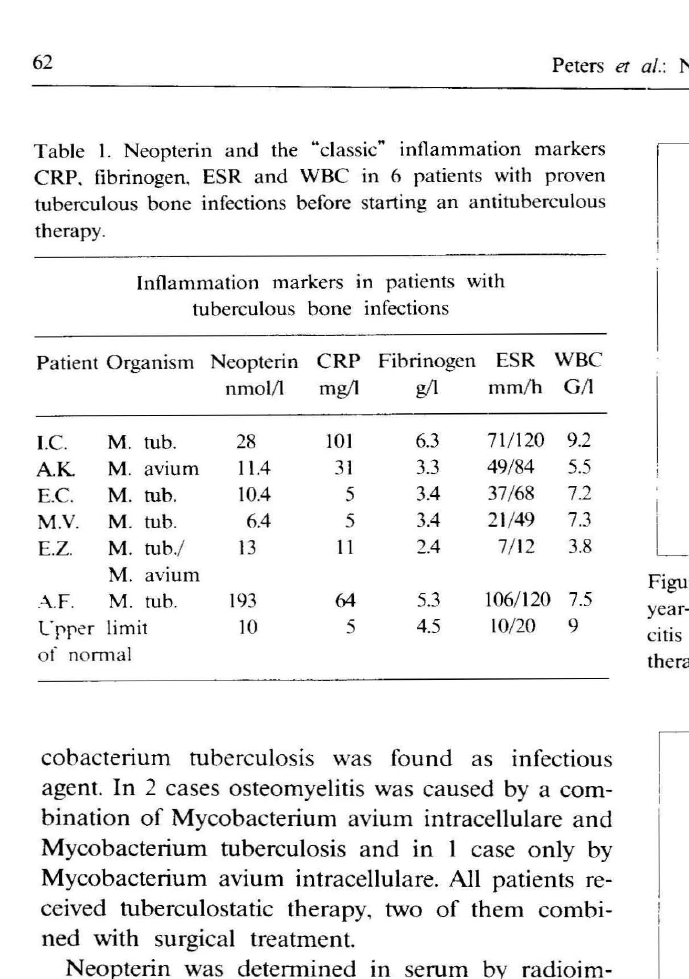
Tuberculous spondylodiscitis